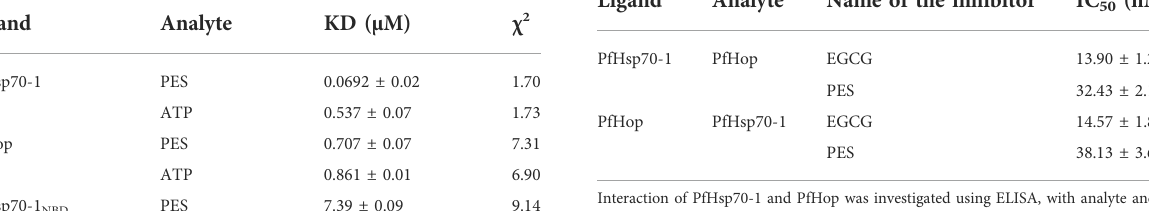
Interaction of PfHsp70-1 and PfHop was investigated using ELISA, with analyte and ligand alternating. IC 50 values for the interaction of the proteins in the presence of PES and EGCG (control) are